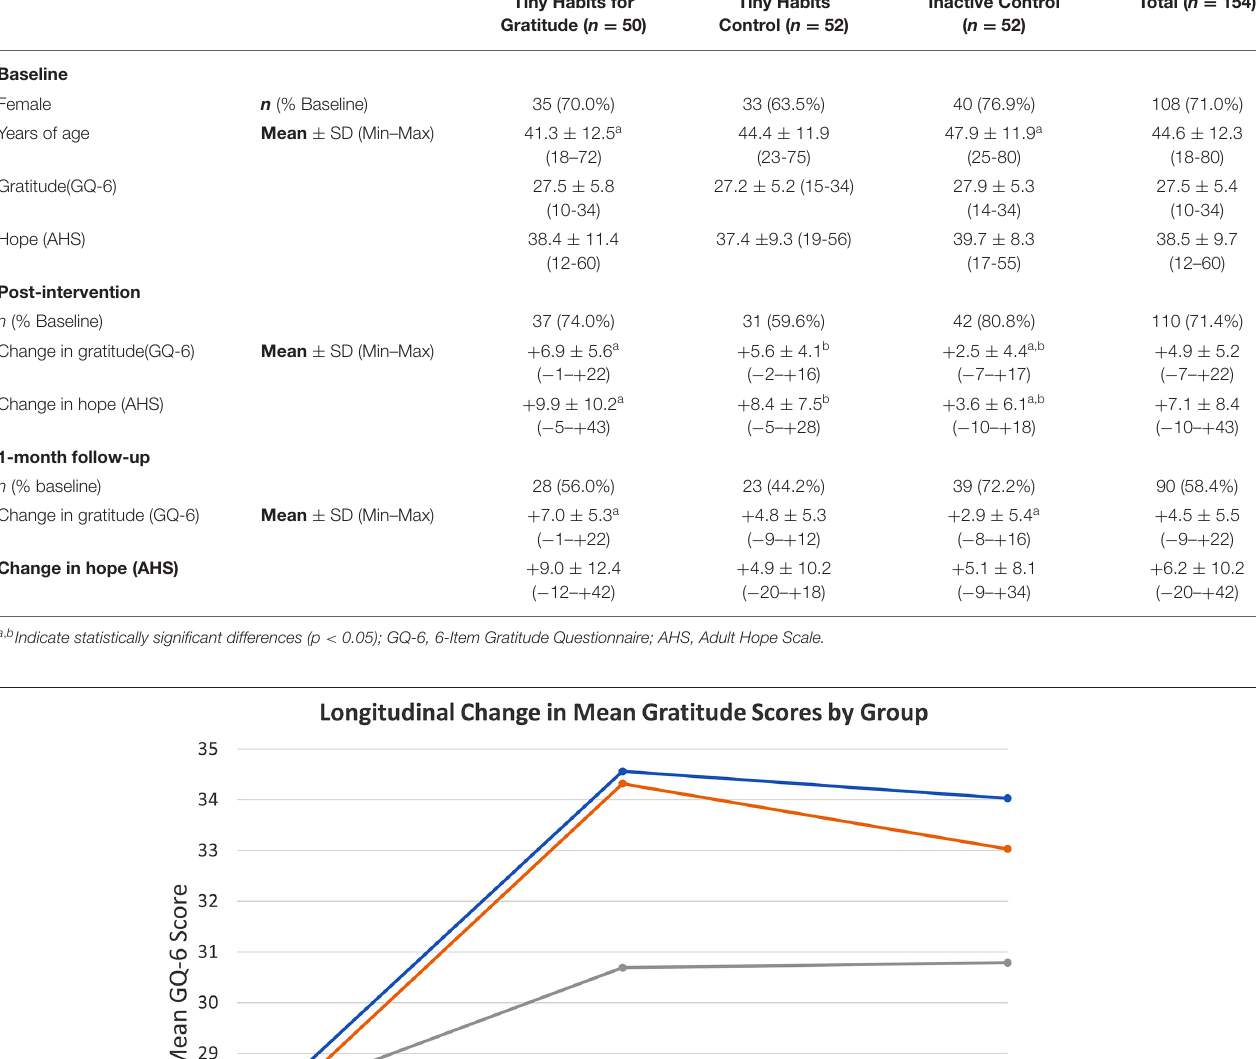
Tiny Habits for Gratitude ( n = 50)